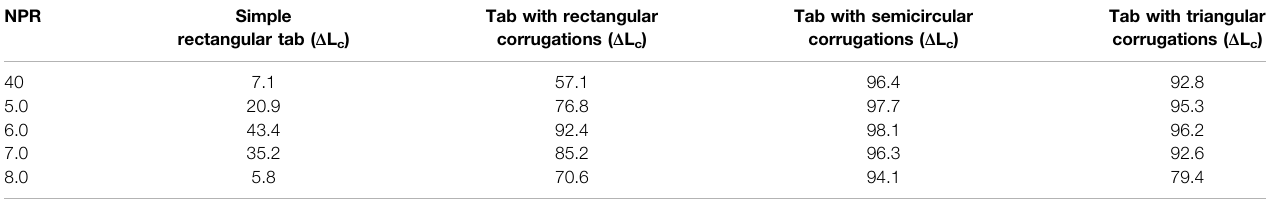
Tab with semicircular corrugations ( Δ L c )